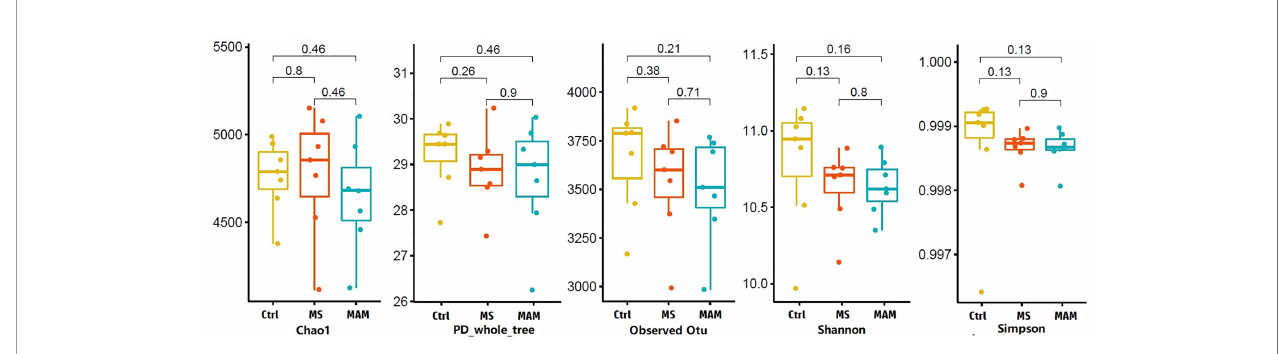
FIGURE 3 | Alpha diversity values for gut microbial communities among different model